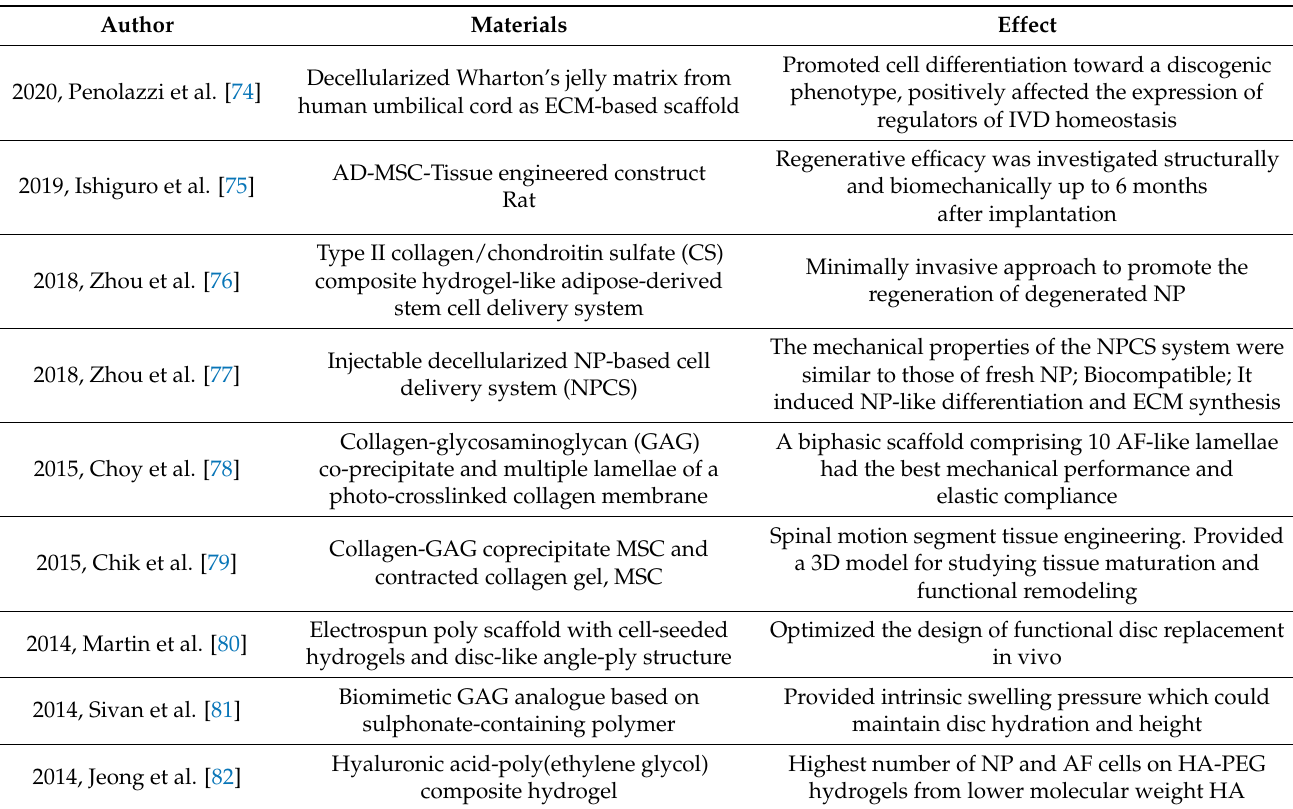
Table 2. Biomaterials for IVD